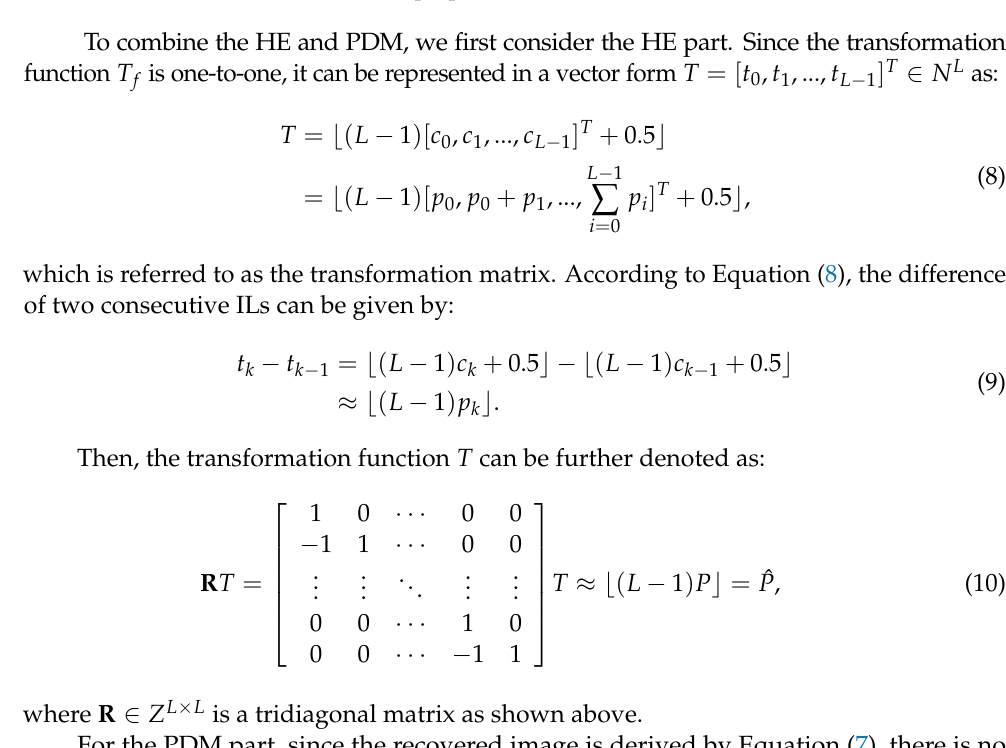
Figure 2. The overall framework of the proposed